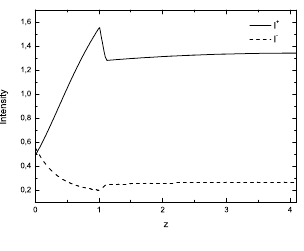
Figure 9. Spatial distribution of laser pulse intensity along the AE at the moment of maximum intensity of outgoing laser pulse.